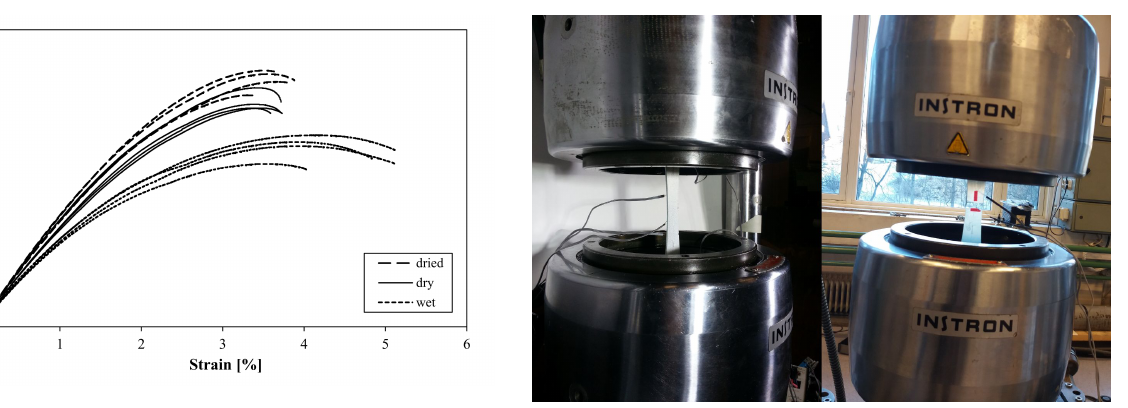
Figure 3: Stress-strain curves of dry, conditioned and dried epoxy specimens.